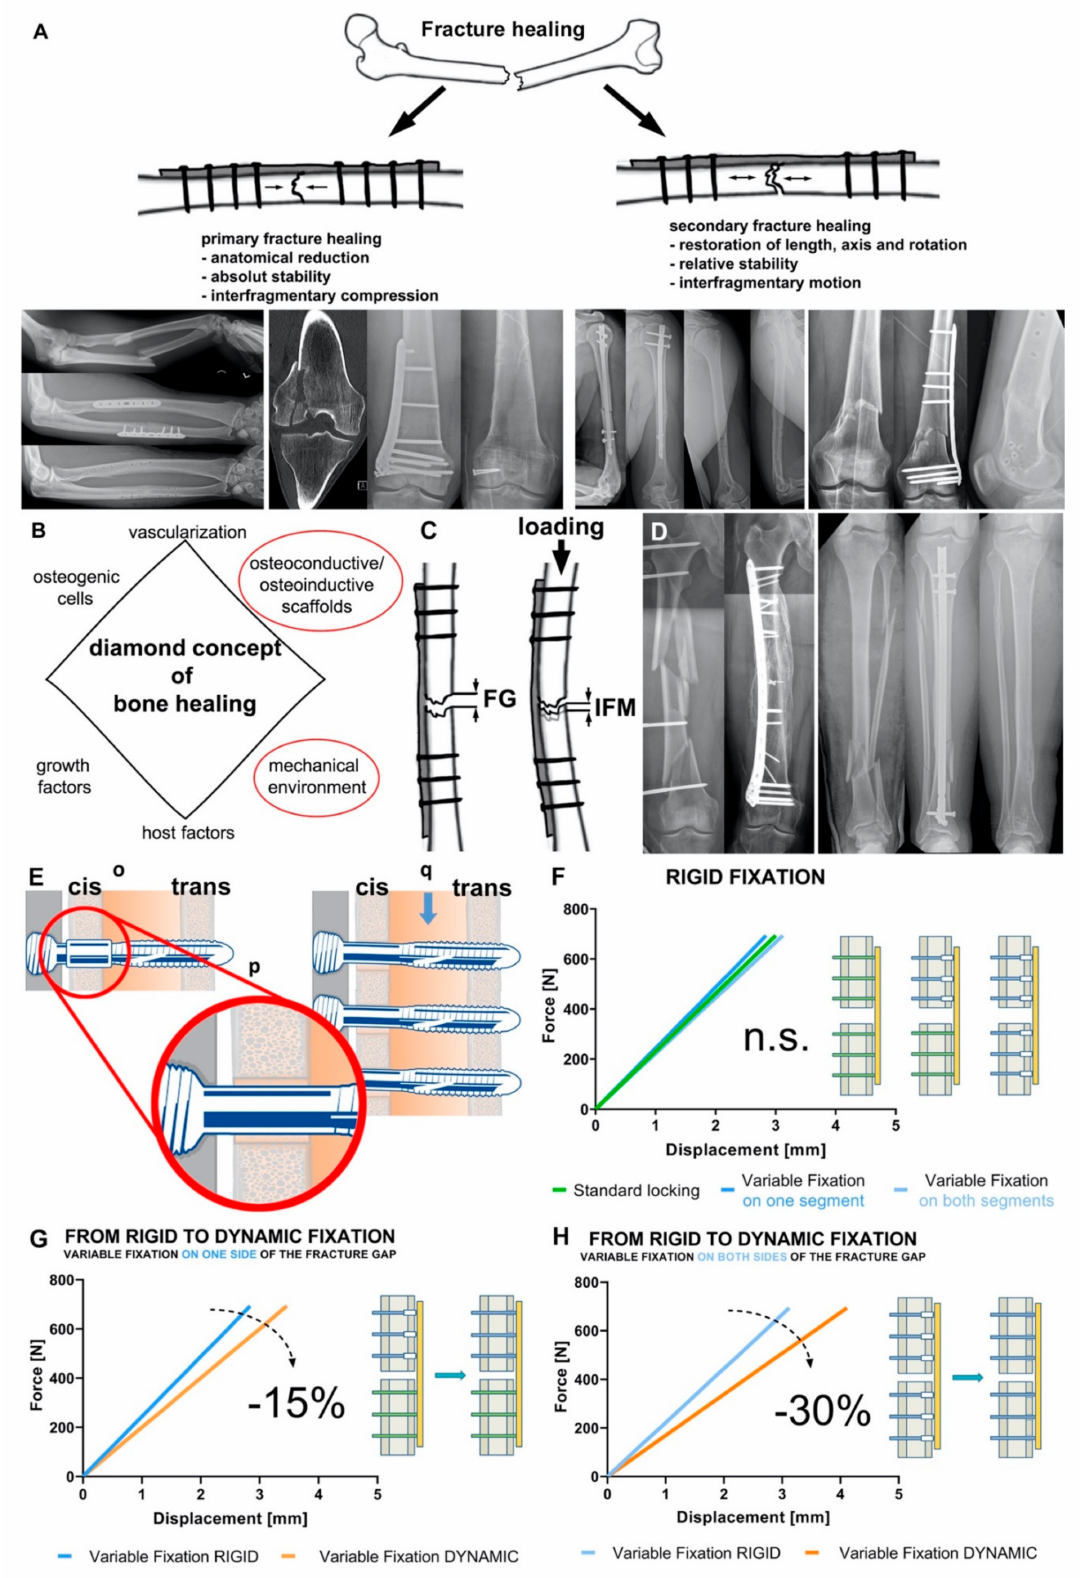
Figure 1. Mechanical environment is crucial for bone homeostasis and fracture healing. ( A ) Types of fracture healing. Primary fracture healing (left) requires interfragmentary compression, the x-rays showing two clinical cases: forearm fracture treated with two compression plates and healing without callus formation and intraarticular distal femur